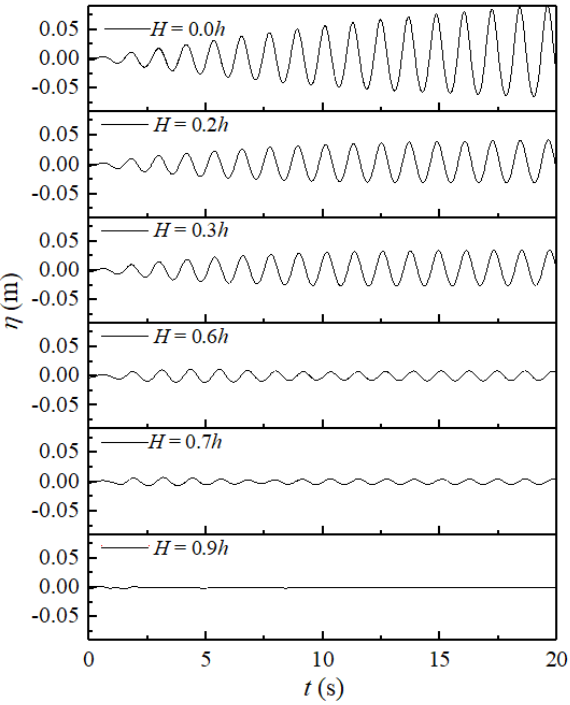
Figure 11. Time series of free surface elevation at y = 0 of sloshing in the tank under different baffle heights.